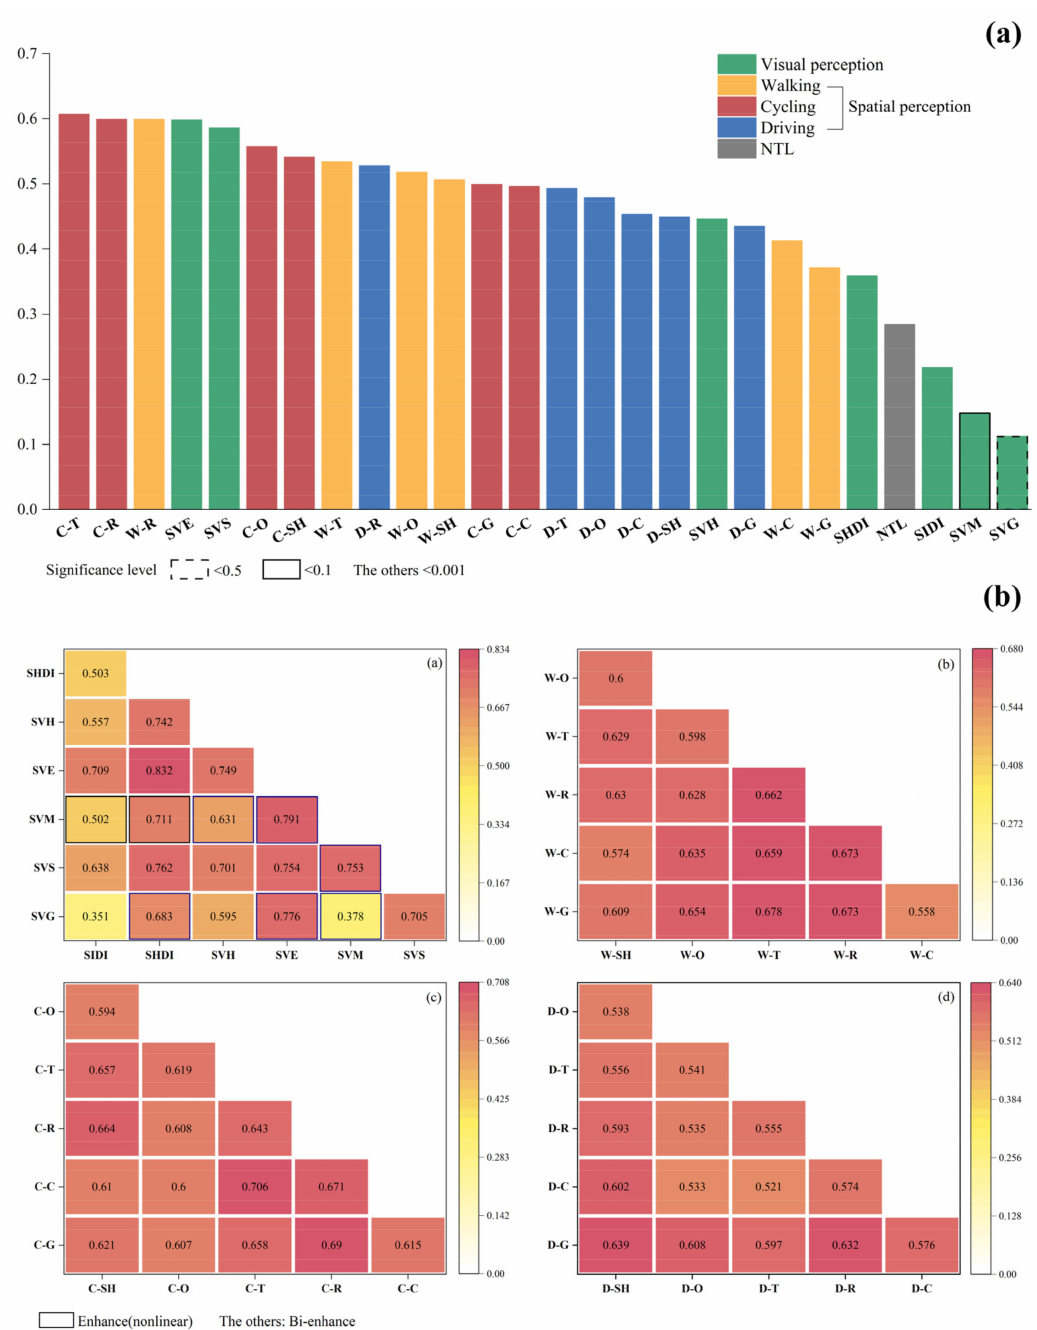
Figure 7. ( a ) Influence of human perception factors on the density of the settled population (DSP), sorted from high to low and ( b ) interactions between human perception factors and